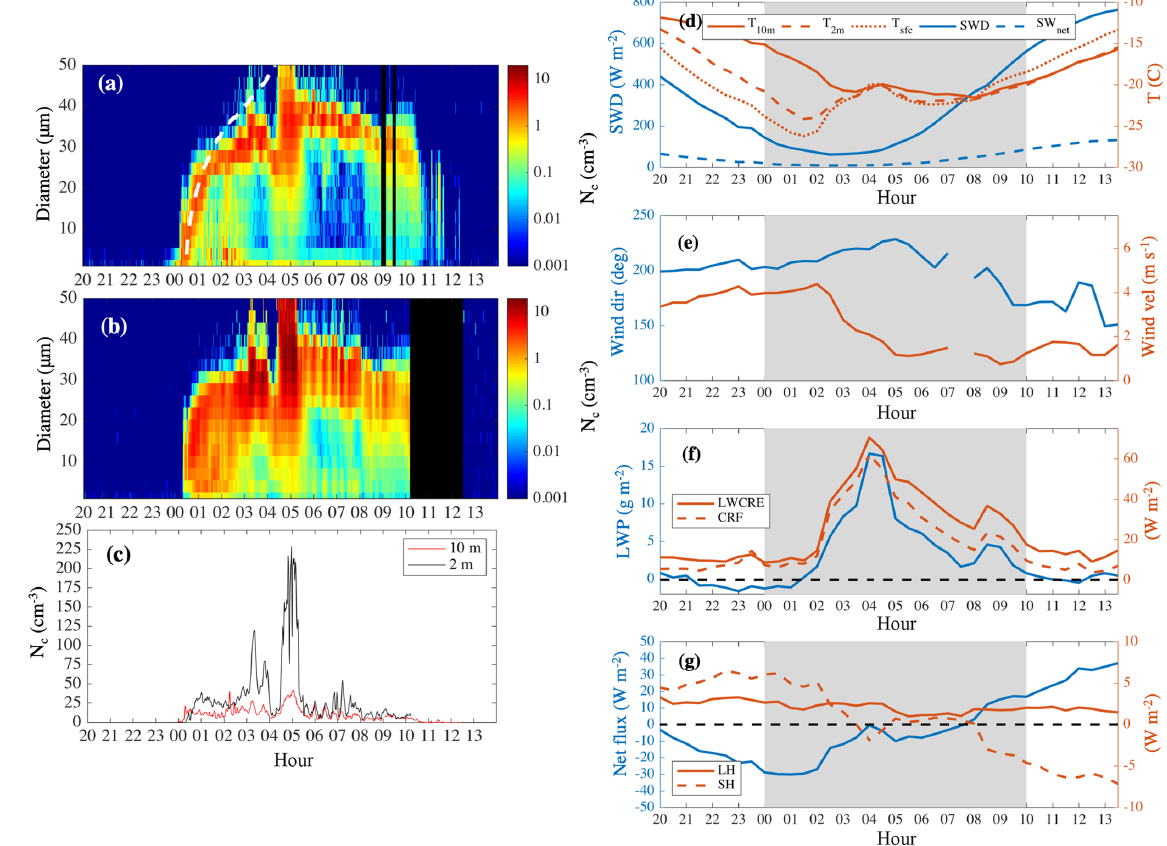
Figure 6. 16 June 2013 case study. Number concentration and particle diameter from FM100 at (a) 10m and (b) 2m. (c) Total number concentration ( N c ) in all bins for the 10m FM100 (red) and the 2m FM100 (black). (d) Temperatures at surface (skin), 2 and 10m (reds) and downwelling shortwave radiation (SWD) and net shortwave radiation (SW net ) (blues). (e) Wind direction (blue) and velocity (red). (f) Longwave cloud radiative effect (LWCRE) and total cloud radiative forcing (CRF) (reds) and liquid water path (LWP) (blue). (g) Latent (LH) and sensible (SH) (reds) turbulent fluxes and net flux (blue). The white dashed line in panel (a) is a theoretical growth curve calculated from Houghton